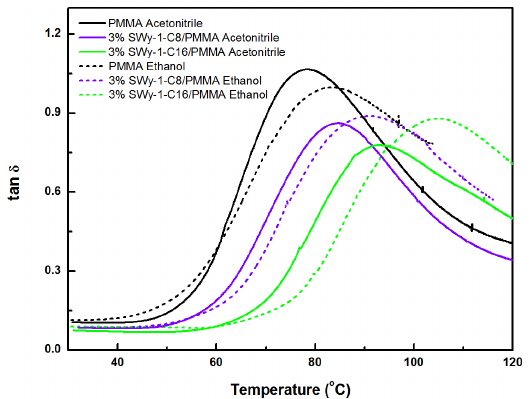
Figure 3. Temperature dependence of tan δ for PMMA and nanocomposites synthesized in acetonitrile and ethanol.